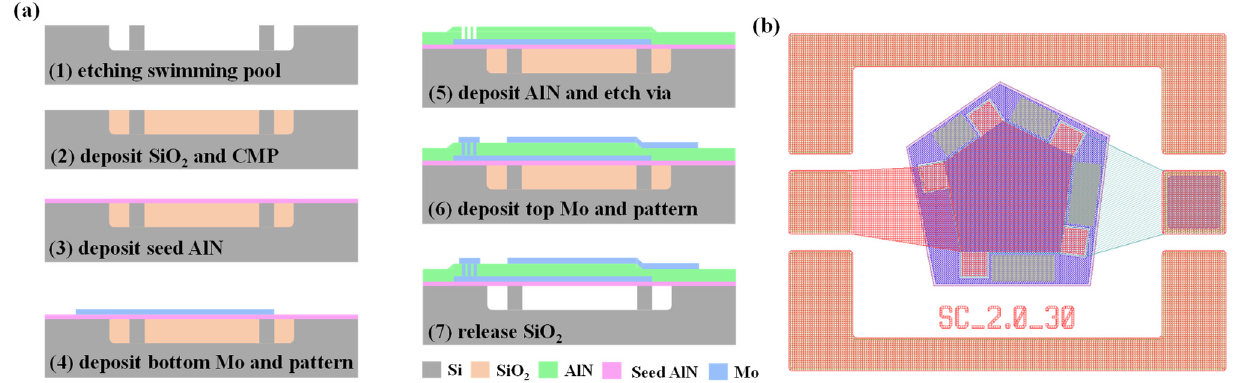
Figure 4. ( a ) Flow diagram of the fabrication process for the device. ( b ) The layout of the designed device.